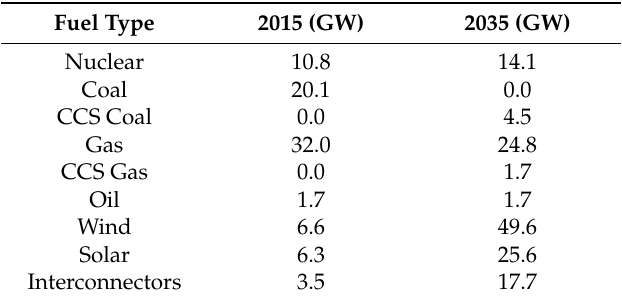
Table 2. Energy mix summary in the year 2015 and